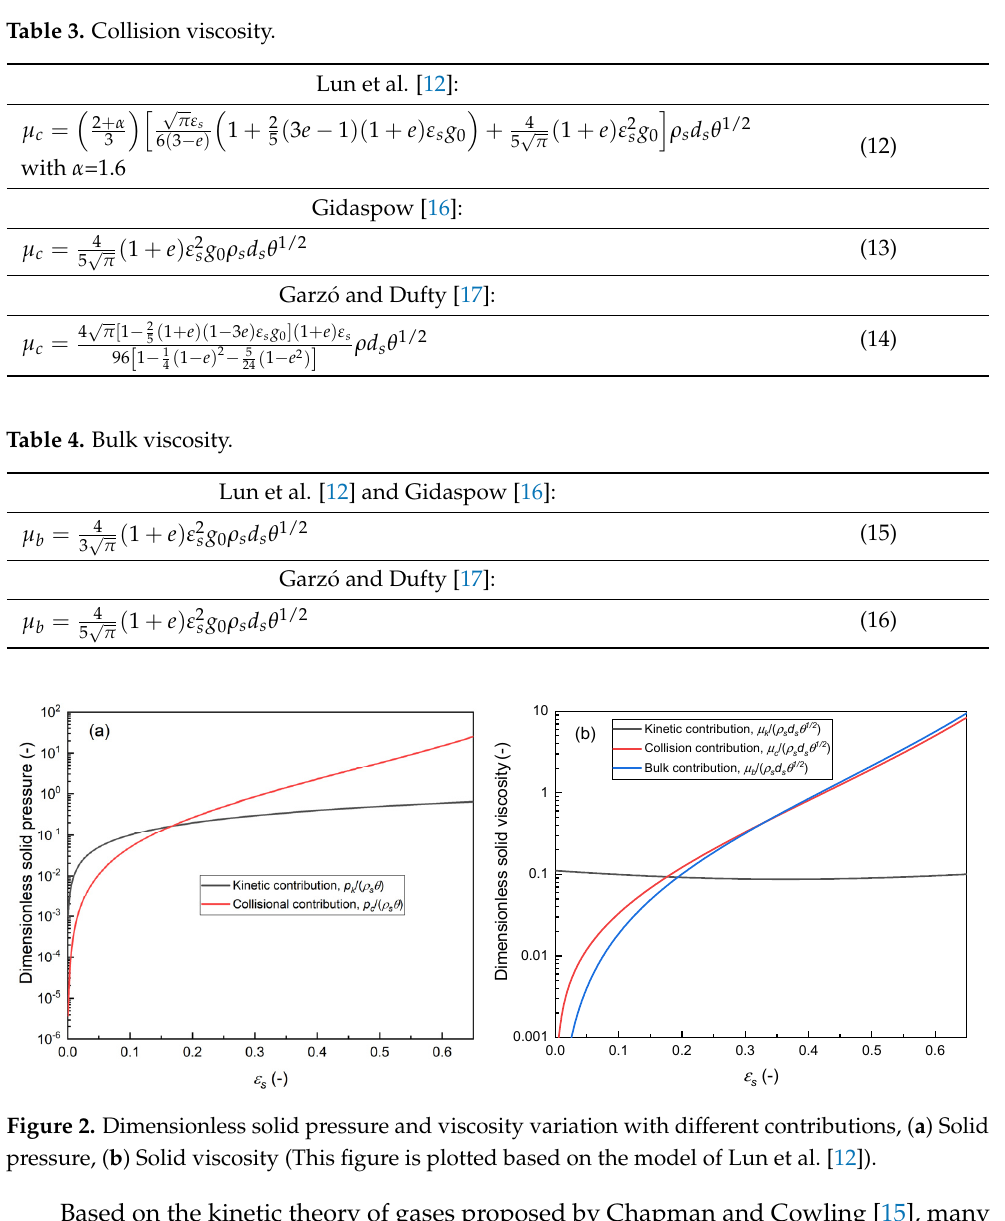
Table 3. Collision viscosity.